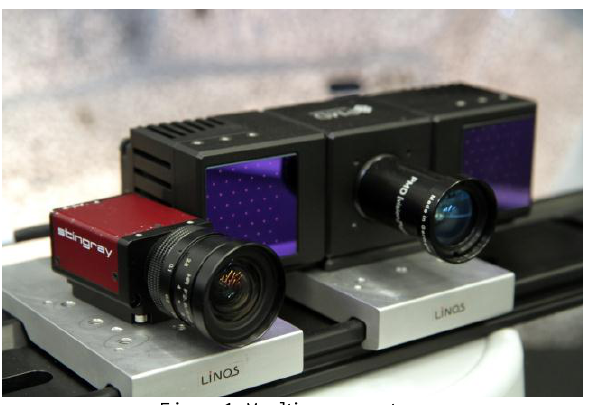
Figure 1. Multisensor system.